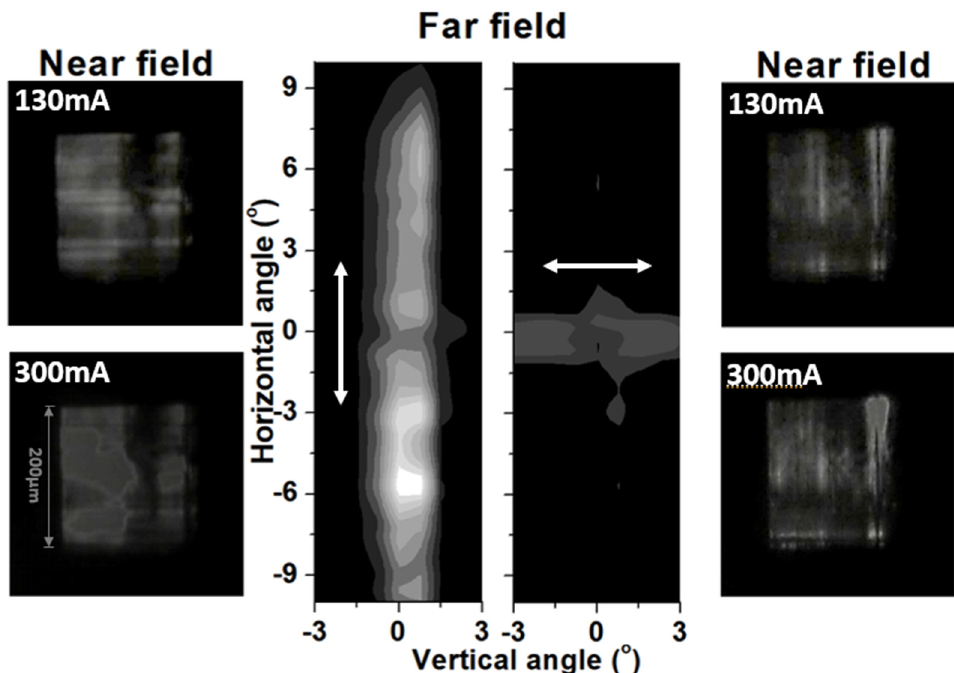
Figure 4. Near and far field patterns measured at 160 K for two electric field polarizations (direction are shown by arrows in the far field plots). The far field patterns were measured in a 1% duty cycle regime (100 ns/100 kHz) well above the threshold (at 500 mA). Near field patterns were measured at 0.1% duty cycle (100 ns/10 kHz) below (top images) and above (bottom images) the threshold.